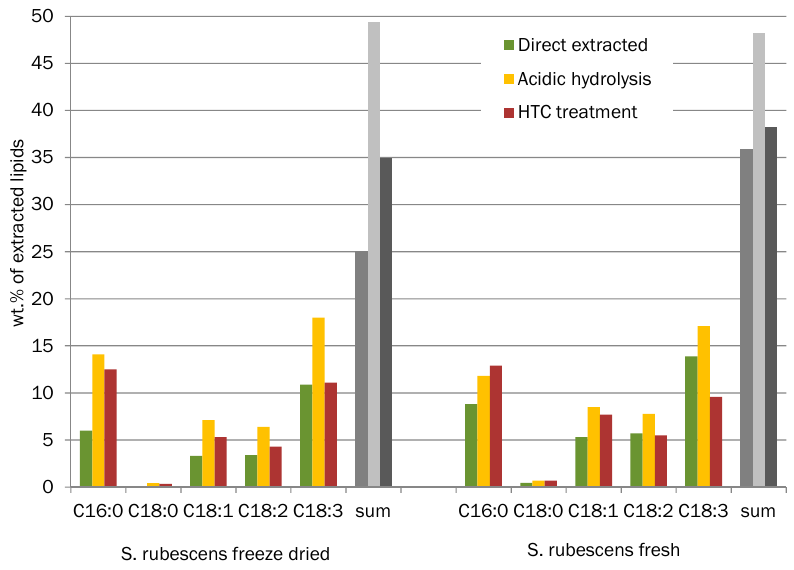
Figure 2. wt.% of main fatty acids and percentage of recognized fraction of S. rubescens .